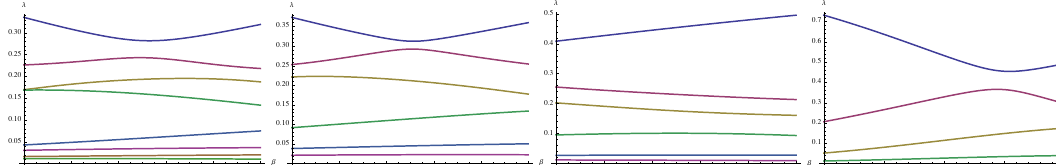
) is shown in black. L